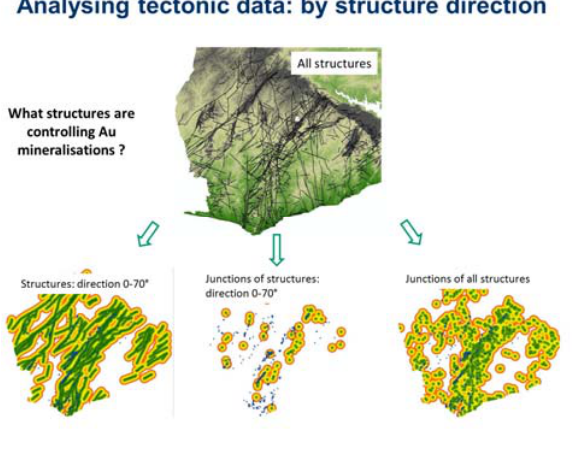
Figure 8. Pre-processing of tectonic data